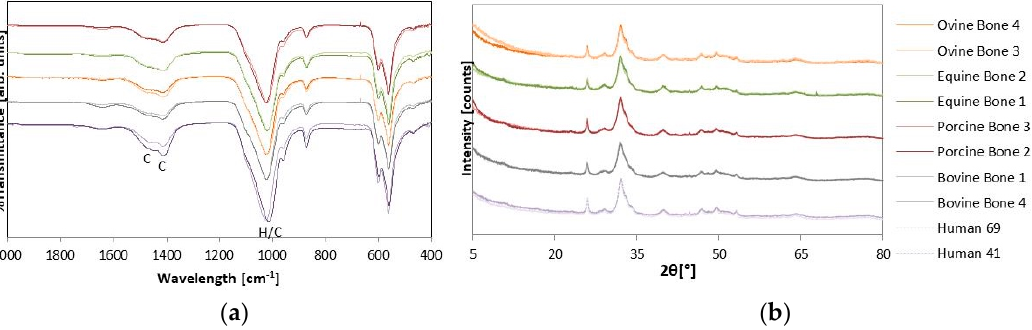
Figure 5. ( a ) FT-IR spectra of the animal and human precursors: bands characteristic of CHA (1455, 1419, 875 cm − 1 ) [43,44] and HA (1090, 1030, 600, 570 cm − 1 ) [45,46] and HA (1090, 1030, 963, 602, 566 cm − 1 [47,48] are detected); ( b ) XRD patterns of the animal and human precursors: all peaks detected are characteristic of hydroxyapatite.